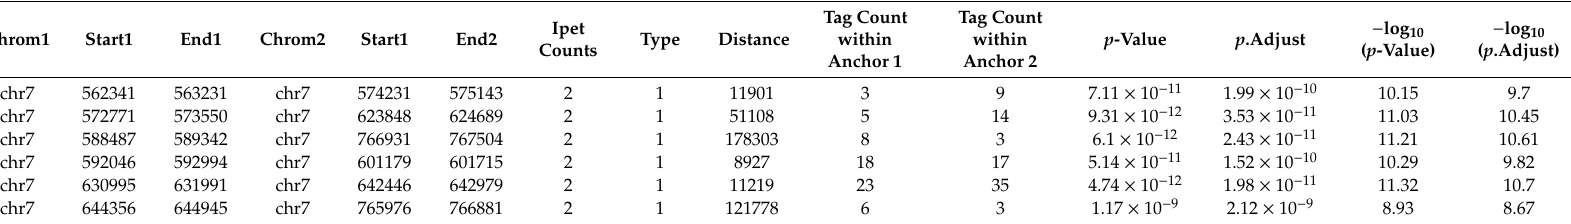
Table A2. Example of interaction